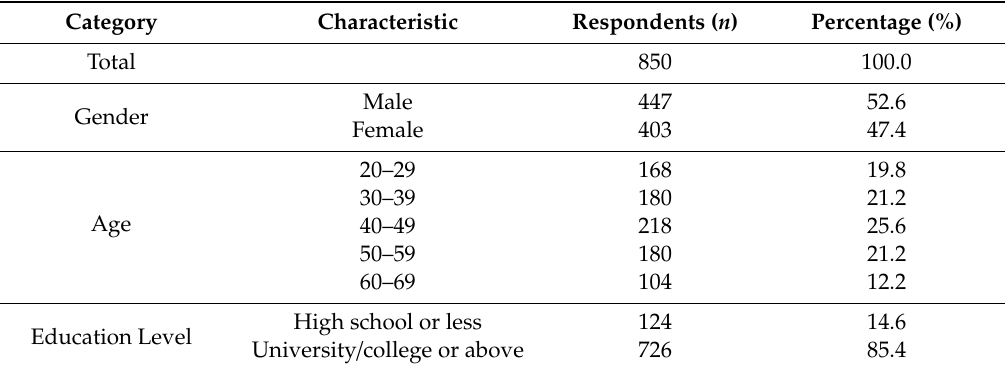
Table 1. Demographic properties of